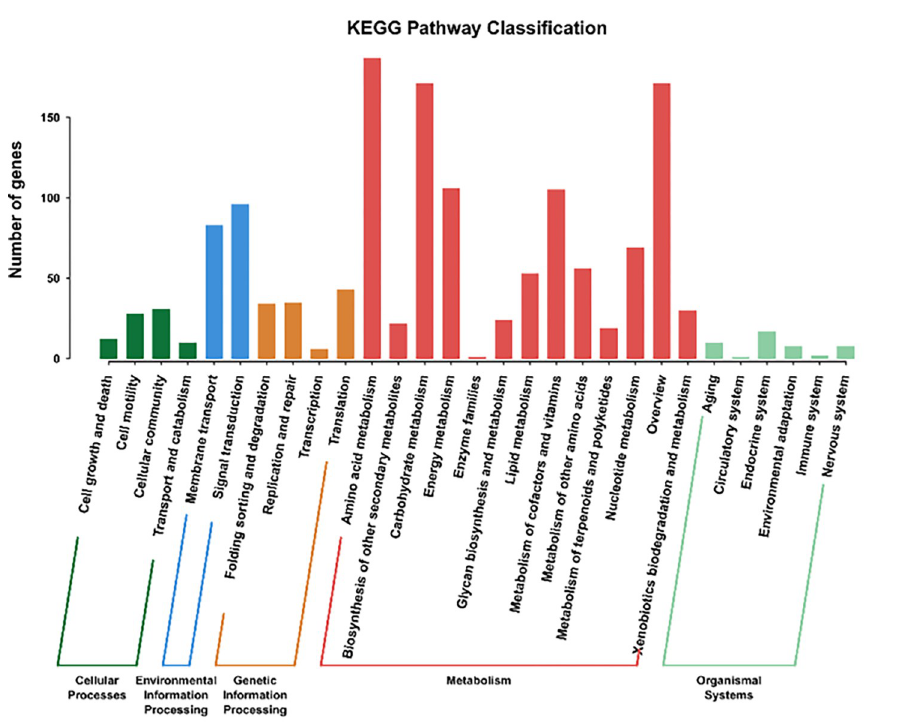
Fig 3. KEGG metabolic pathways. X-axis indicates different KEGG categories and Y-axis indicates the number of genes related to KEGG pathway.